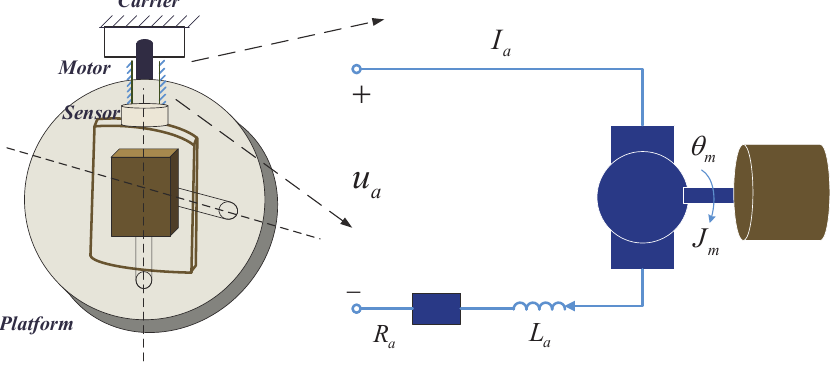
Figure 1. Platform system